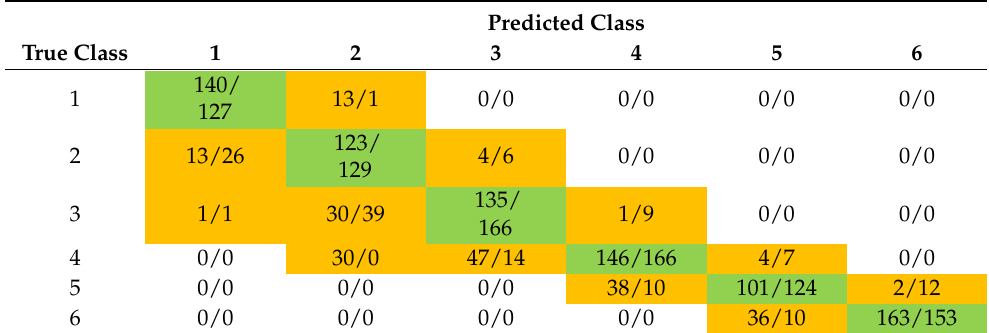
Figure 9. Accuracy of harmonic current level classifiers for exact load models using pretrained networks. Table 6. Truth table for 7th harmonic classifier of SFC at Bus 9 for both metering scenarios Base 6 and Opt 6 ( Base 6/ Opt 6).